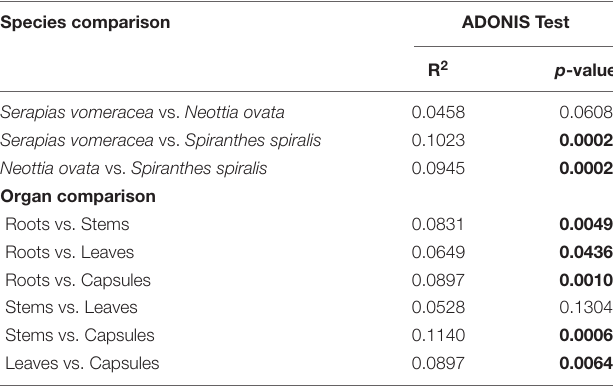
TABLE 2 | ADONIS pairwise comparisons of microbiota structure between orchid species and organs, calculated on Bray–Curtis dissimilarity measures. Species comparison ADONIS Test R